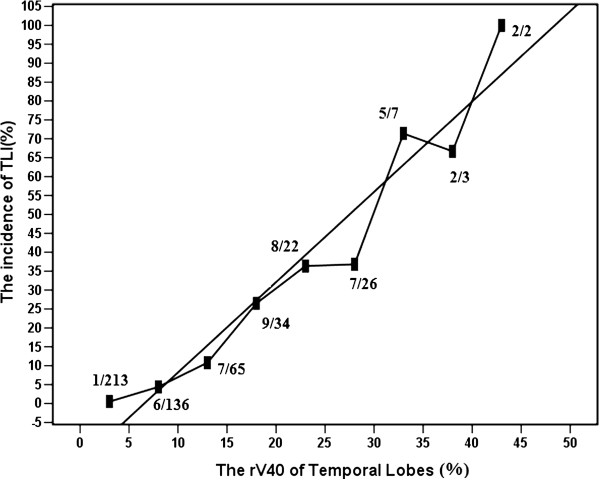
Plot of 5-year incidence as function of rV40 for temporal lobes.